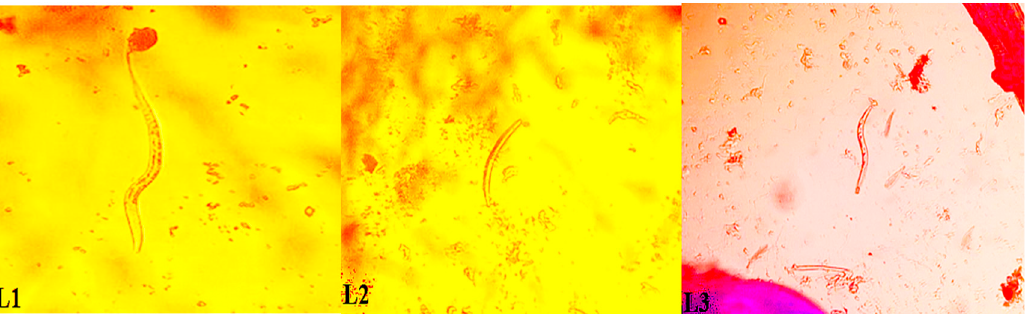
Figure 1. Three larval stages of W. bancrofti parasites from Ahanta West district in Ghana .